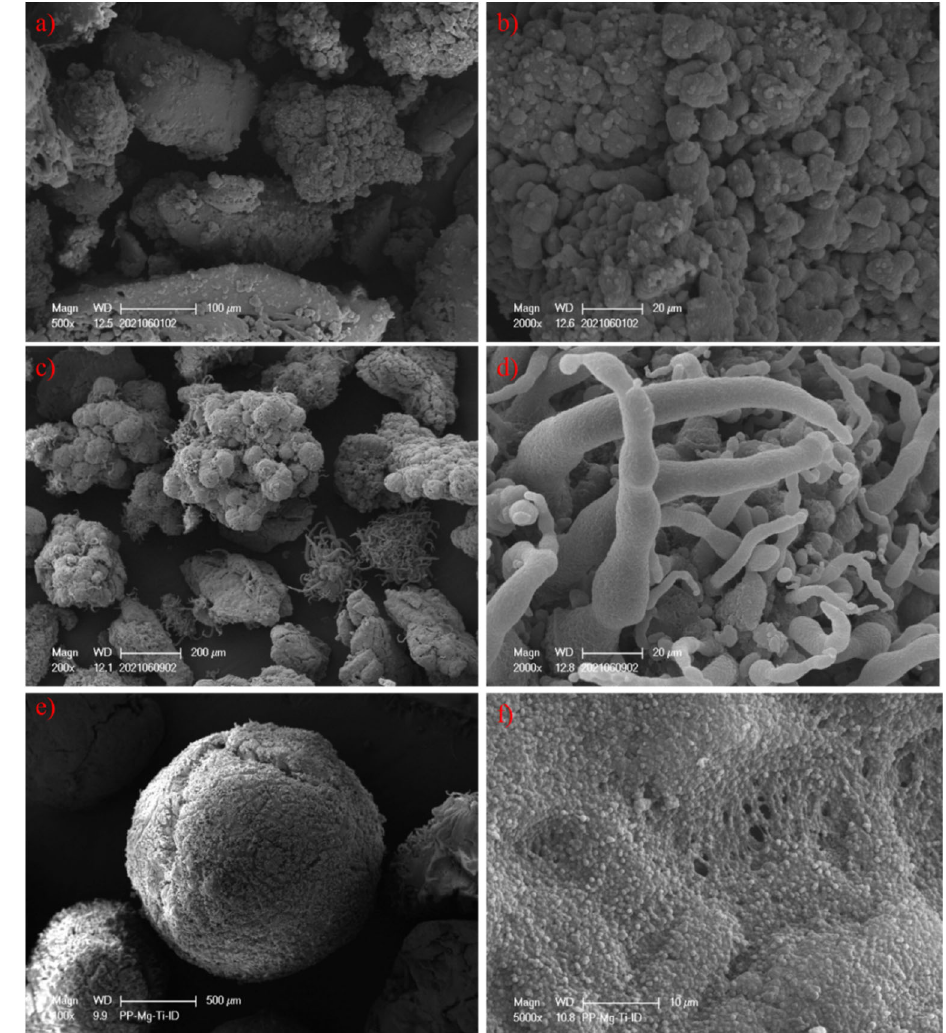
Figure 9. SEM photos of PP ‐ 1 from cat ‐ 1 ( a , b ); PP ‐ 2 from cat ‐ 2 ( c , d ); PP ‐ 4 from cat ‐ 4 ( e , f ).